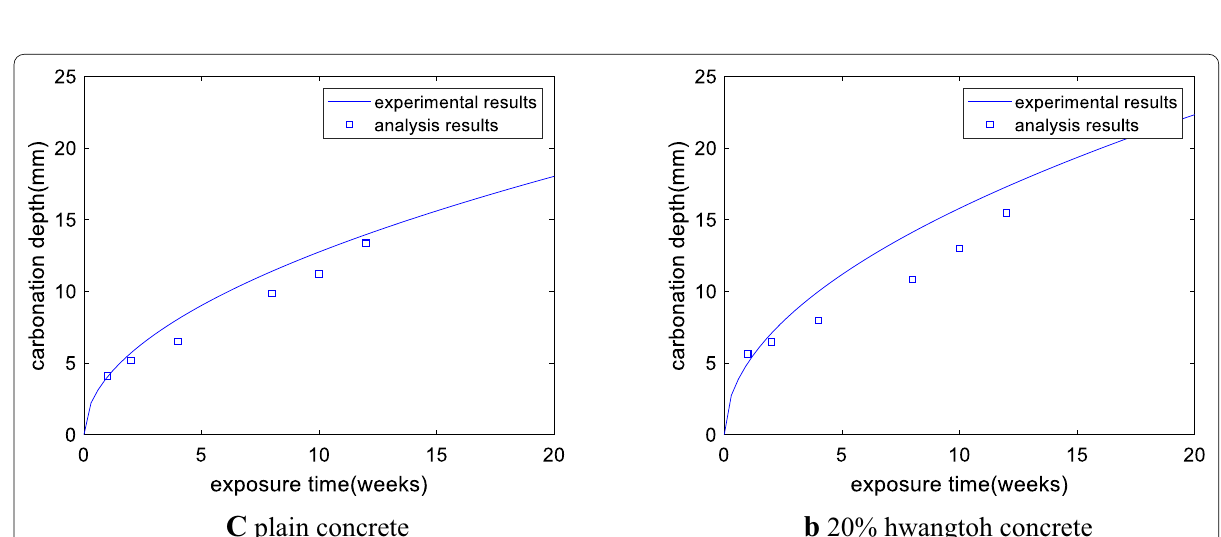
Fig. 11 Evaluation of carbonation depths (Choi et al.